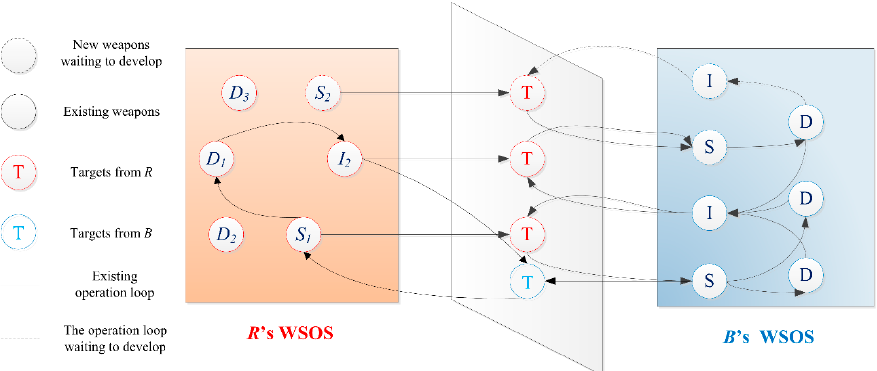
Figure 2. Weapon system of systems nodes location in battle.